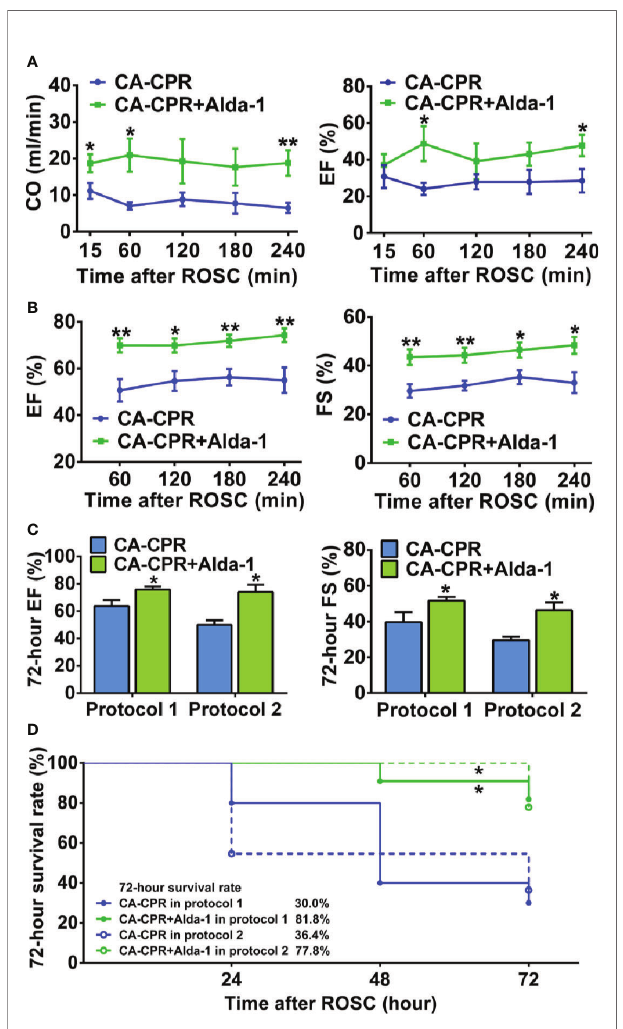
FIGURE 2 | The effect of ALDH2 activation by Alda-1 on post-cardiac arrest myocardial dysfunction and survival rate. (A) Left ventricular cardiac output (CO) and ejection fraction (EF) evaluated by Millar pressure-volume catheter within 4 h after ROSC in protocol 1 of the ALDH2 activation study ( n = 6 animals per group). (B) Left ventricular EF and fractional shortening (FS) evaluated by echocardiography within 4 h after ROSC in protocol 2 of the ALDH2 activation study ( n = 9 animals per group). (C) Left ventricular EF and FS evaluated by echocardiography at 72 h after ROSC in the two protocols of the ALDH2 activation study ( n = 3 – 9 animals per group). (D) Kaplan-Meier survival curves within 72 h after ROSC in the two protocols of the ALDH2 activation study. Myocardial function between groups was compared by Student ’ s t-test and time-based measurements within each group were compared by repeated-measures ANOVA. The survival rate between groups was compared by the log-rank test. Data are presented as mean ± SEM. * P < 0.05, ** P < 0.01 versus CA-CPR